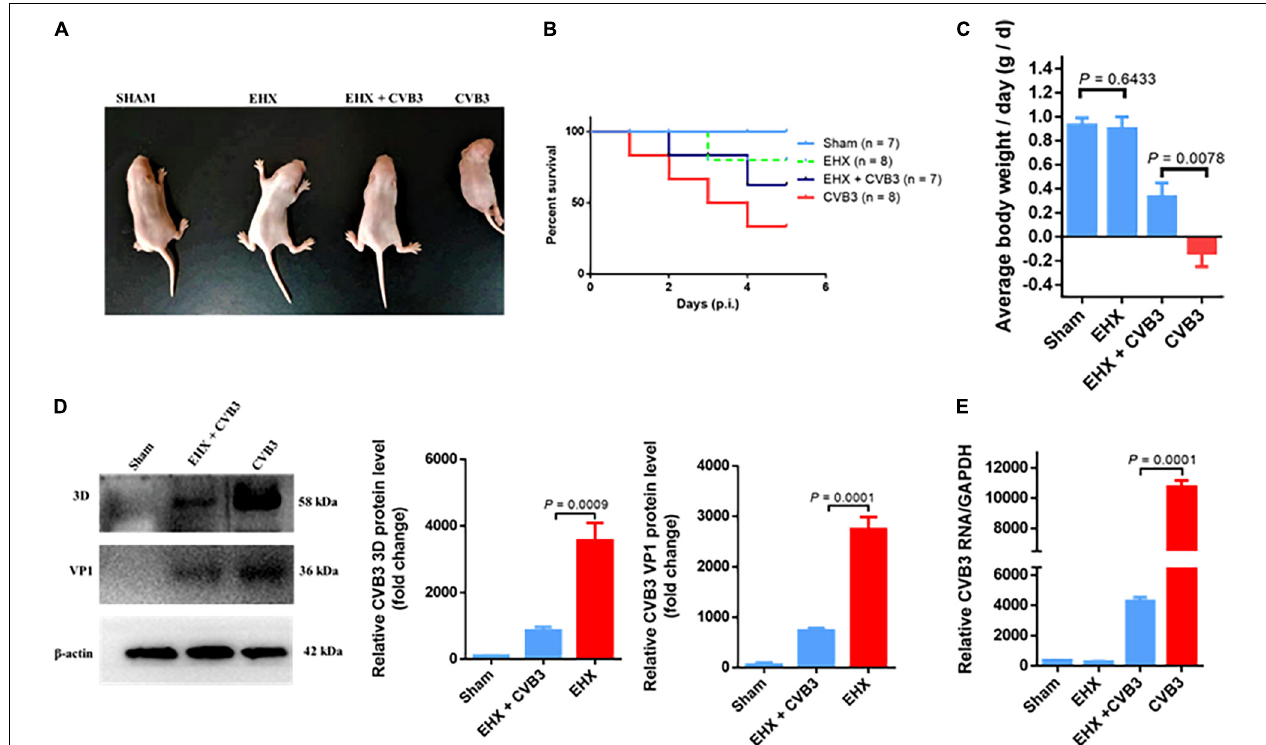
FIGURE 3 | EHX inhibits CVB replication in virus-infected mice. Suckling mice (5 days old) were infected with CVB3 and were treated with EHX (250 mg/kg) two times a day for 5 days. (A) Representative picture of the overall physical condition of each mice group. (B) Survival rate of each mice group. (C) Average change in mouse bodyweight per day was calculated using the formula: (body weight-body weight of the previous day)/5 days. (D,E) EHX inhibits the viral protein and RNA level. Total protein and RNA were analyzed using Western blotting and RT-qPCR at the end of day 5 pi, respectively. Error bars represent SD, n = 3, Student’s t